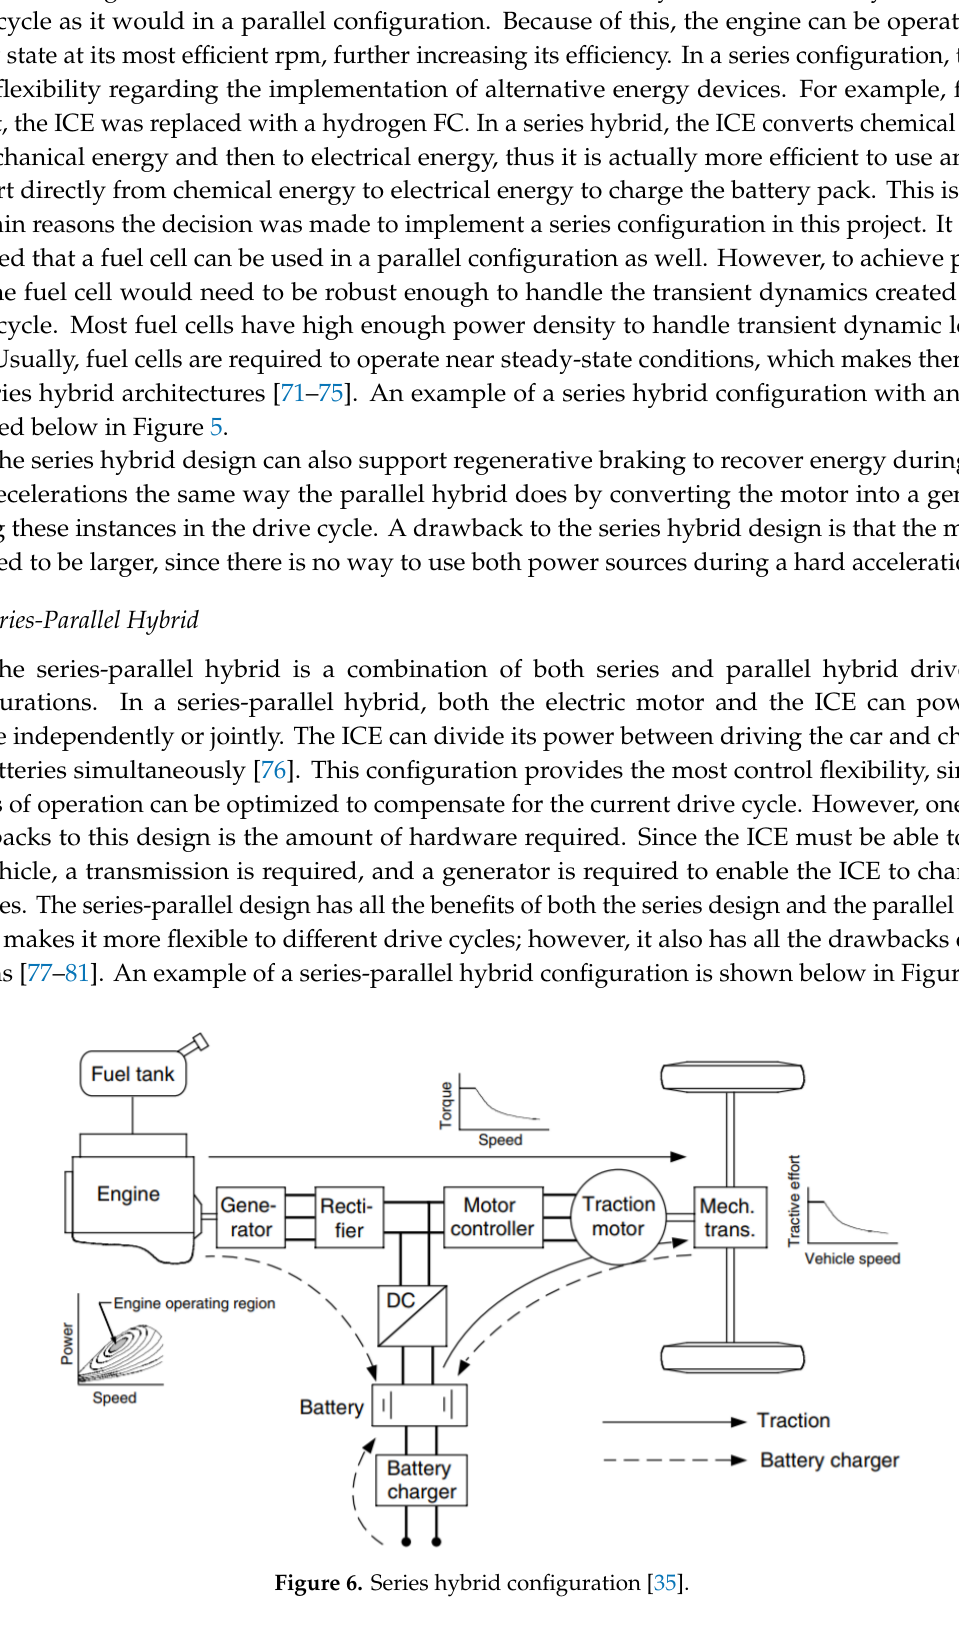
Figure 5. Parallel hybrid configuration [69].